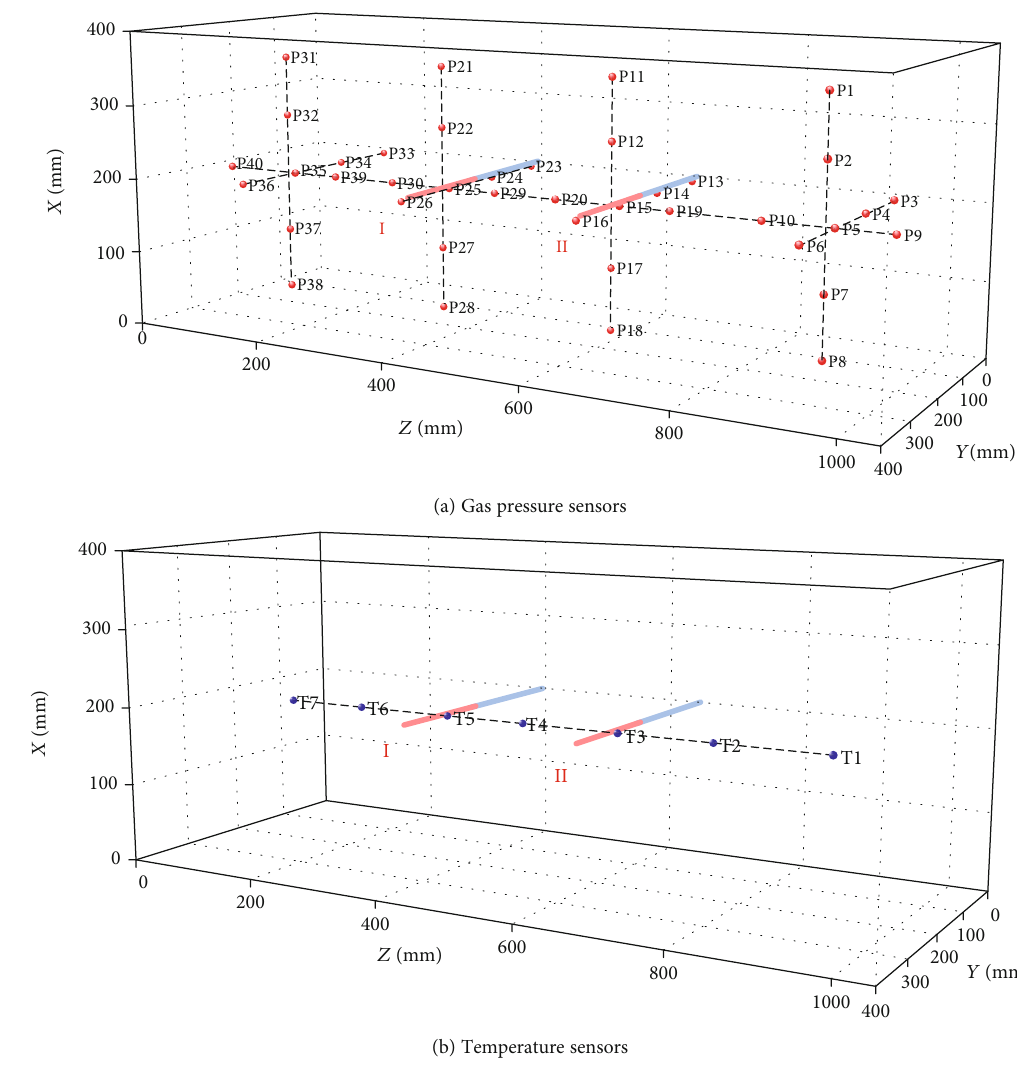
Figure 1: Positions of gas pressure sensors and temperature